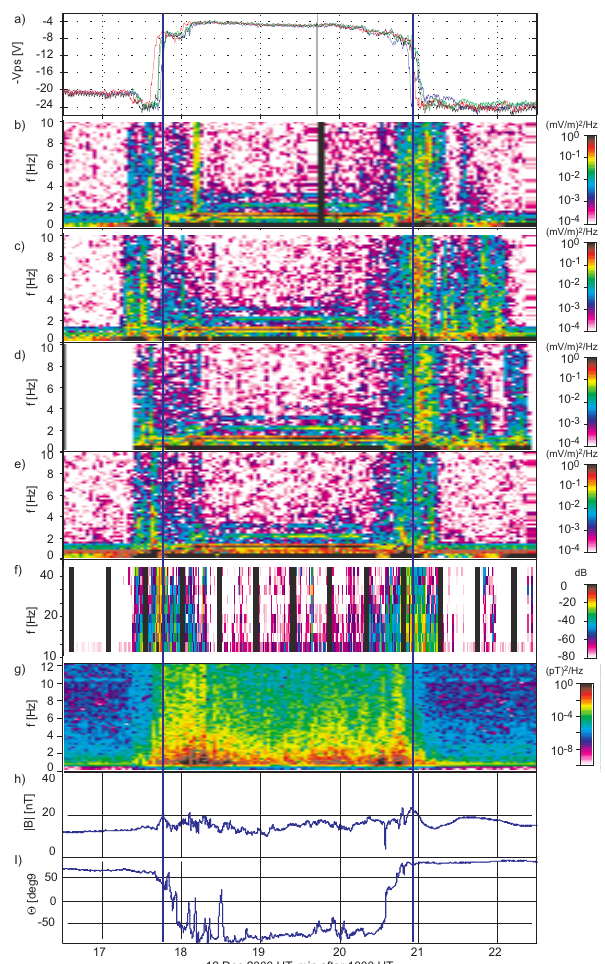
Fig. 3. Cluster observations from 31 December 2000. This display corresponds to the latter part of Fig. 2, and the upper seven panels are similar to that figure. (Note the data gap during the first minute in panel (d) . Panels (h) and (i) show the magnitude of the magnetic field from FGM on satellite 4, and the elevation angle of this field (so that 90 ◦ corresponds to a strictly northward field),